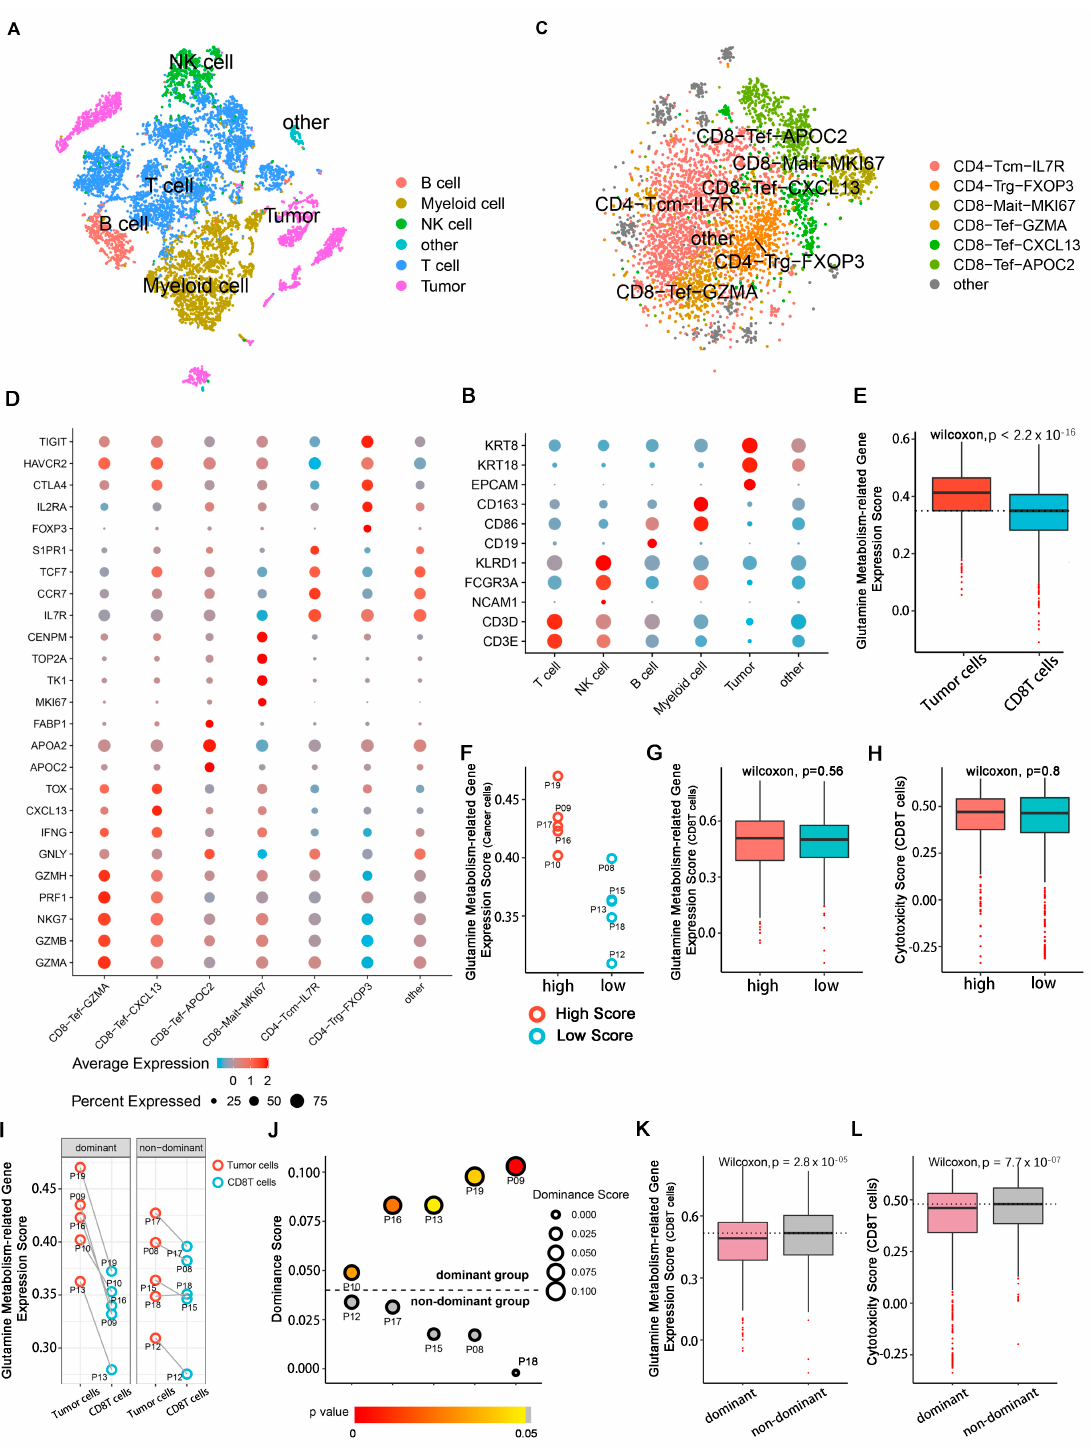
Figure 2. Cell annotation and HCC patient grouping in single-cell RNA-seq. The single-cell RNA sequencing data were downloaded from the China National GeneBank (https://db.cngb.org/search/project/CNP0000650/ (accessed on 15 March 2022). ( A ) t-SNE plot showing the cell subpopulations in the TME derived from HCC patients. Each cluster is color-coded ac- cording to cell type. Cluster annotations are indicated in the figure. ( B ) Dot plot showing the ex- pressions of marker genes in each cell subpopulation. The colors of the dots indicate the average